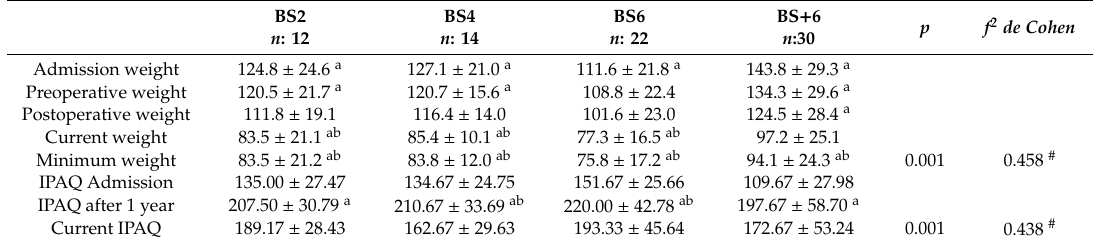
Table 3. Differences in weight, waist circumference, body mass index, percentage of excess weight loss, physical activity level, and quality of life between the groups (mean ± standard deviation).